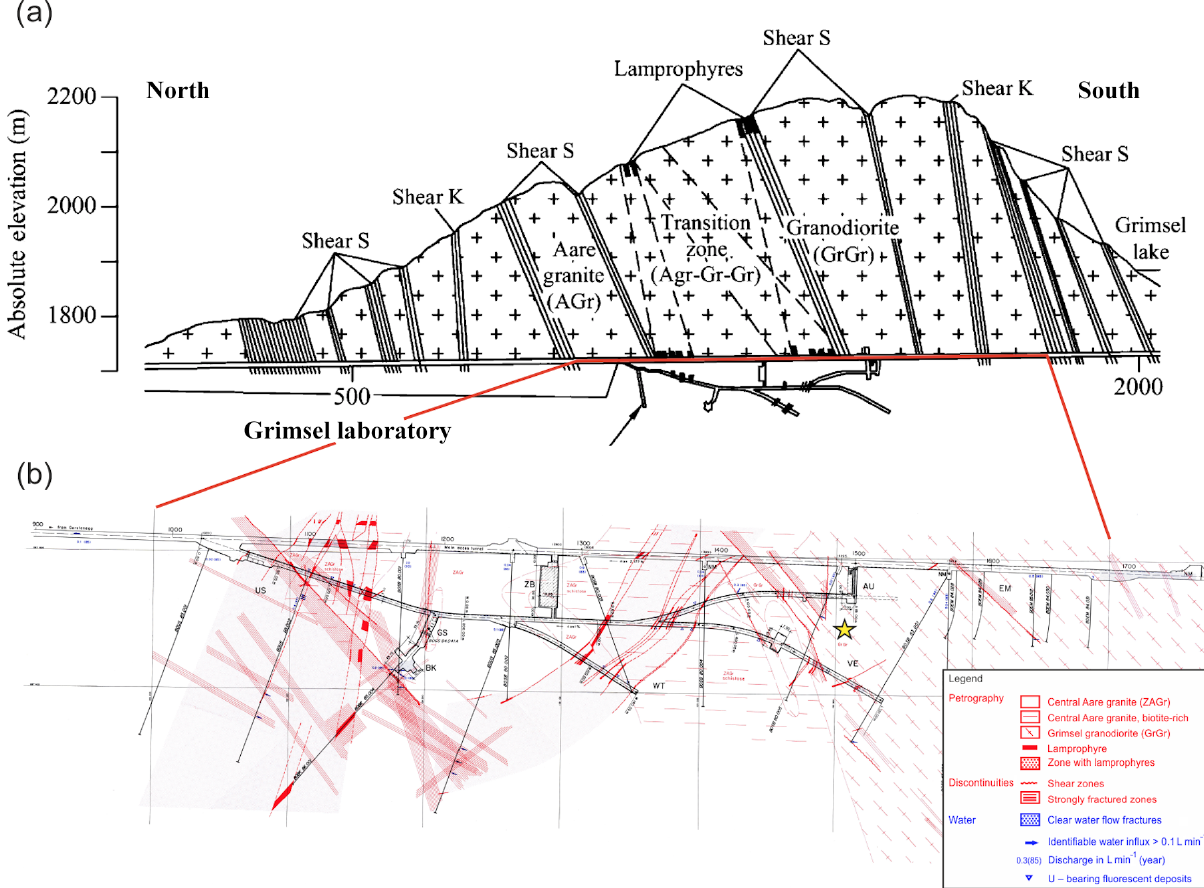
Figure 1. (a) The Grimsel Laboratory and the FEBEX Drift (after Alonso et al., 2005); (b) detailed map view of the FEBEX drift for reference only (After Keusen et al., 1989 and from NAGRA Technical Report